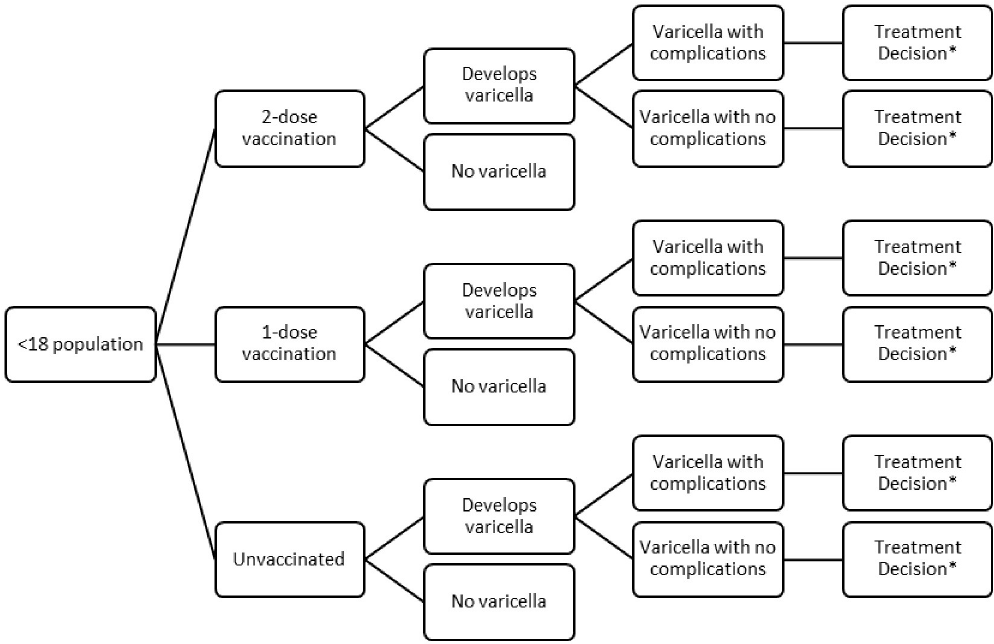
Fig 1. Varicella model structure. Varicella Model Structure: This figure represents the vaccination states of patients and possible treatment decisions within our model. � � � Treatment decisions could be antibiotic therapy, antiviral therapy, both, or none for each varicella